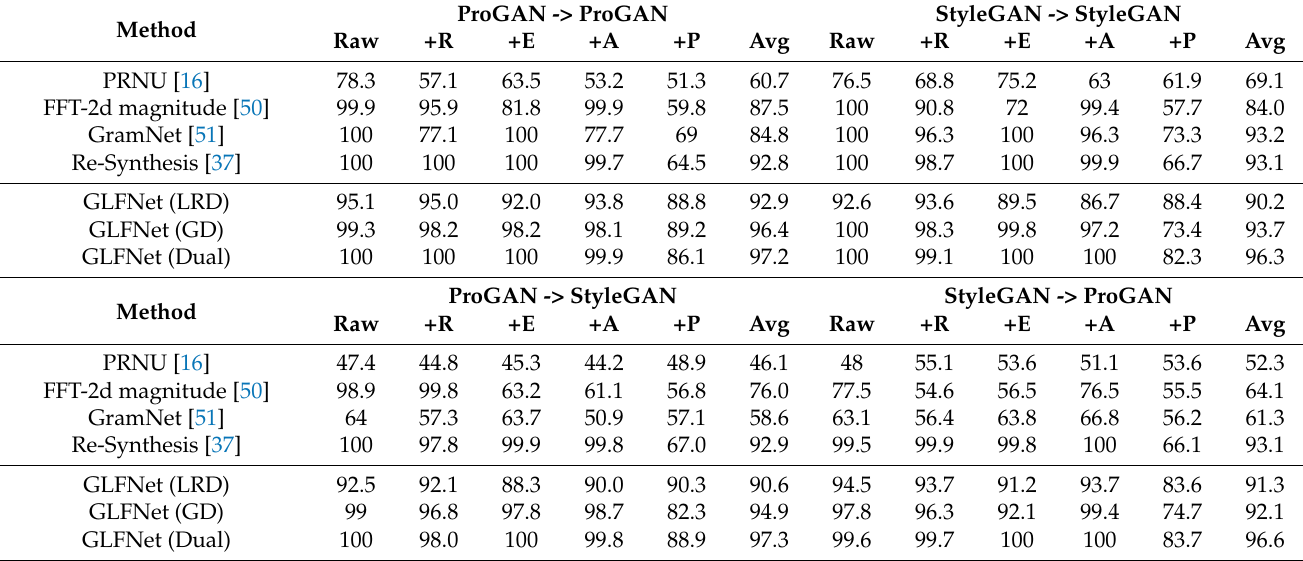
Table 6. Comparison of classification accuracy (%) with baselines.